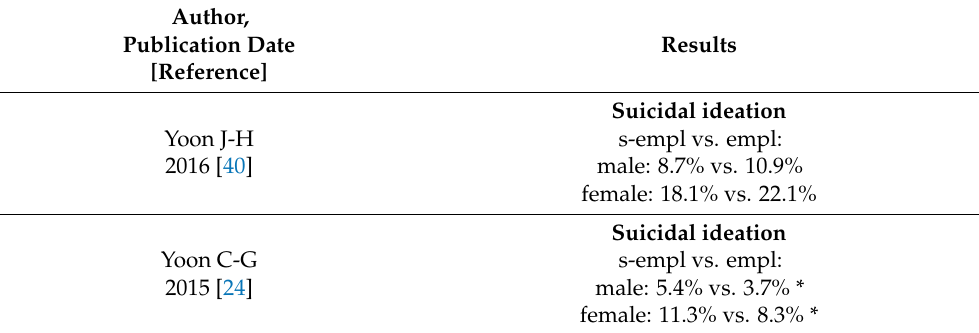
Table 7. Suicidal thoughts —results of cross-sectional studies of good quality on mental disorders comparing self-employed (s-empl) vs. employees (empl).